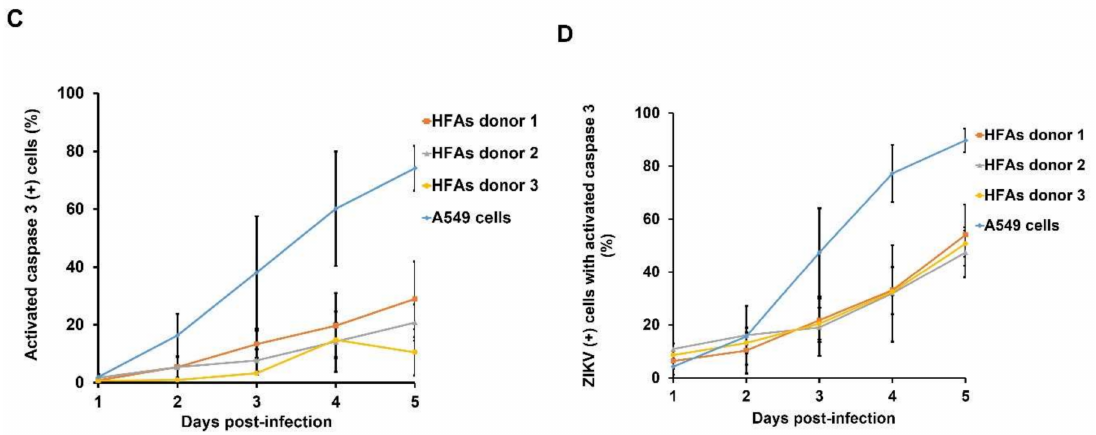
Figure 4. Apoptosis is delayed in ZIKV-infected HFAs. HFAs were infected with ZIKV (MOI = 3) and apoptosis determined by flow cytometry at indicated time points. ( A ) The percentages of HFAs and A549 cells expressing ZIKV envelope protein were determined after 1–5 days post-infection. ( B ) The percentages of viable HFAs and A459 cells remaining after 1–5 days post-infection with ZIKV were determined using an automated cell counter. ( C ) The percentages of HFAs and A549 cells with active caspase-3 are shown. ( D ) The percentages of cells with active caspase-3 among ZIKV-infected HFAs and A549 cells are shown. Values are expressed as the mean of three independent experiments. Error bars represent standard error of the